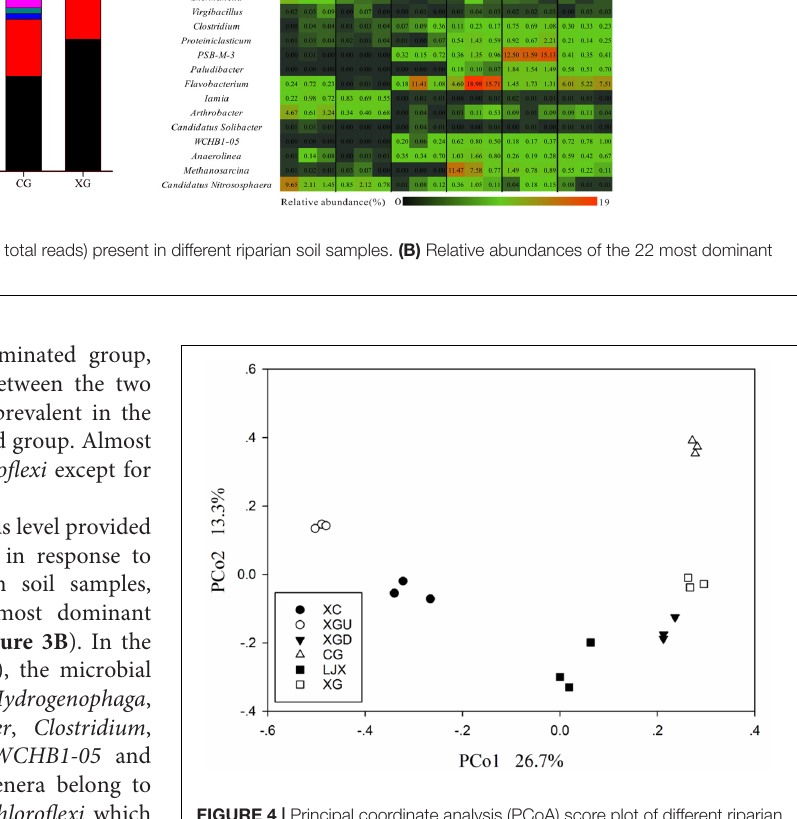
Zn, and Cr showed positive correlations with Mn ( p <